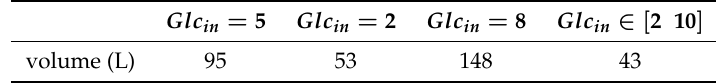
Table 1. Volume of medium fed to the culture for different feed